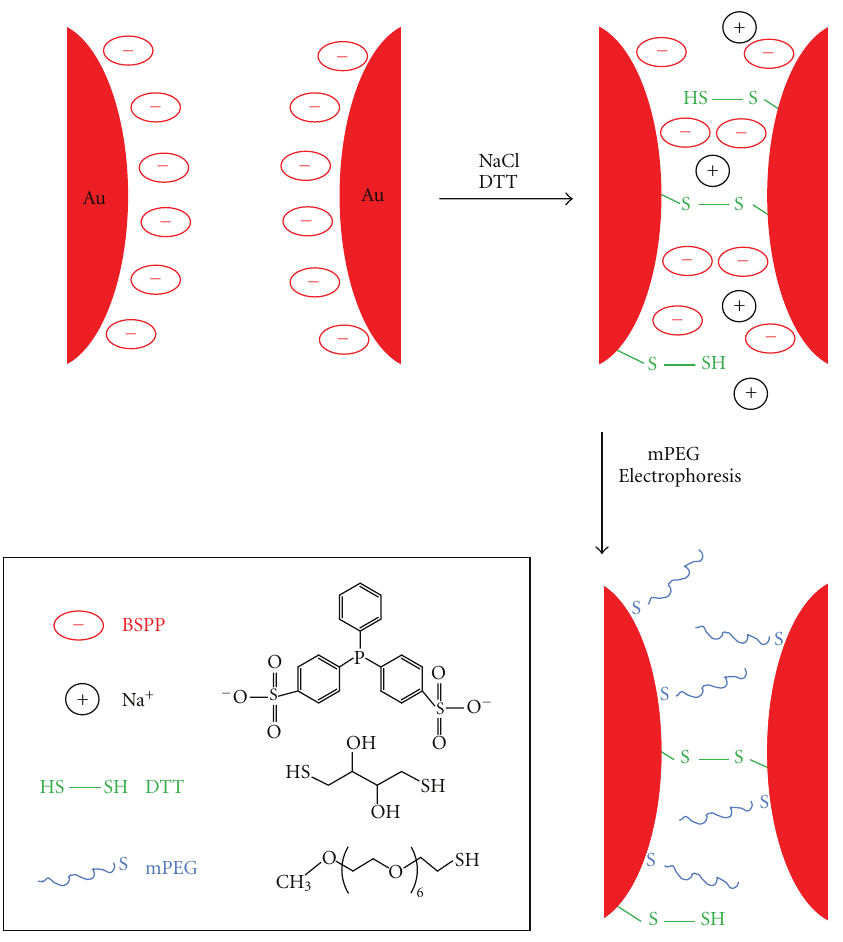
Figure 1: Cross-linking scheme. The single linking DTT molecule is only a schematic representation as several molecules can be involved in the dimer formation. The mPEG excess displaces DTT molecules from the gold surface and can thus break interparticle